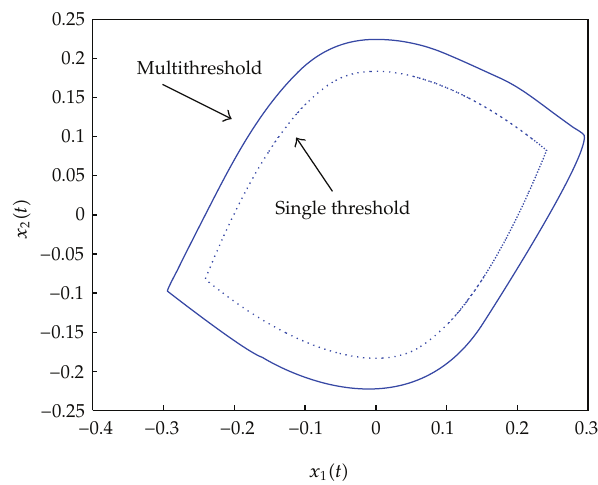
Figure 3: Phase plane plot of the modified sampling criteria for the solution versus its first time derivative exhibiting limit